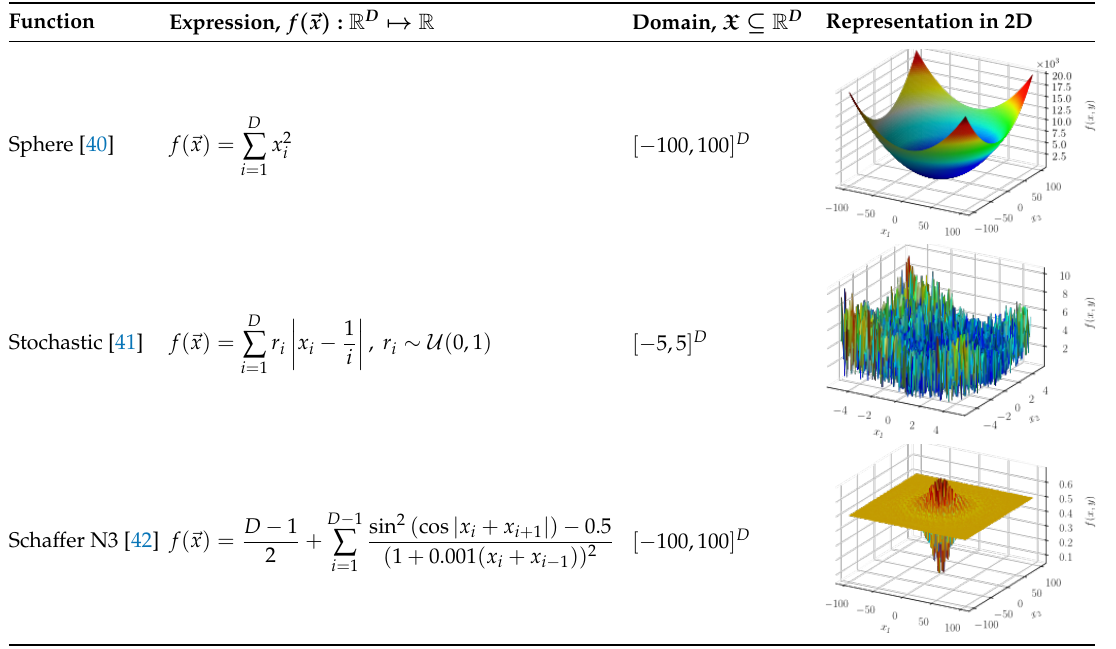
Table 5. Selected benchmark